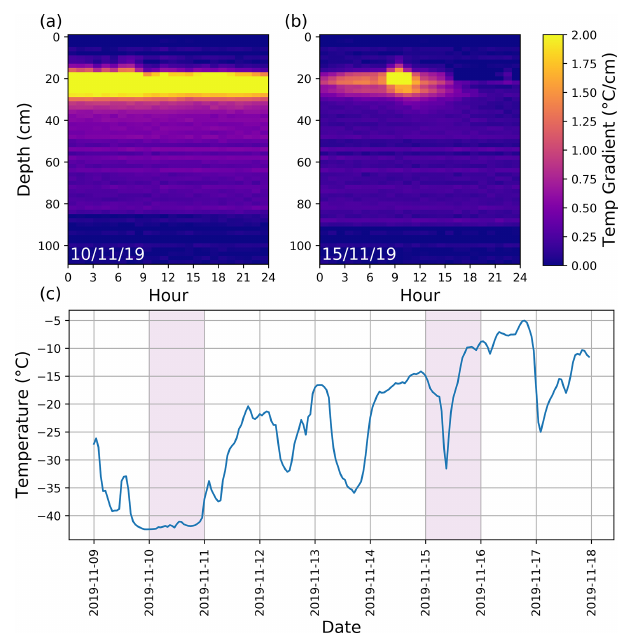
Figure 4. Hourly averaged near-surface, snow and sea ice temper- ature gradient from the RS site, acquired by thermistor strings on (a) 10 and (b) 15 November 2019. The top 20cm represents the distance between the first temperature sensor located above the air– snow interface and the temperature sensor located at the air–snow interface. The bright yellow pixels represent the snow volume. The thermistor string was installed on 7 November 2019. (c) Hourly av- eraged snow surface temperature from the RS site between 10 and 15 November 2019, acquired by the TIR